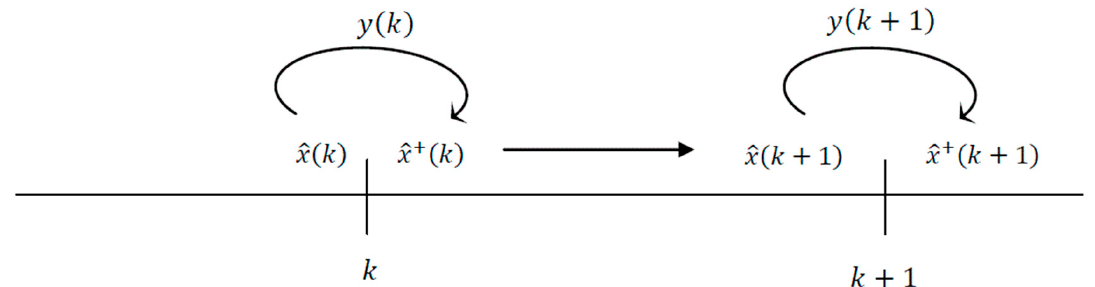
Figure 2. State estimation based on the last measurement.